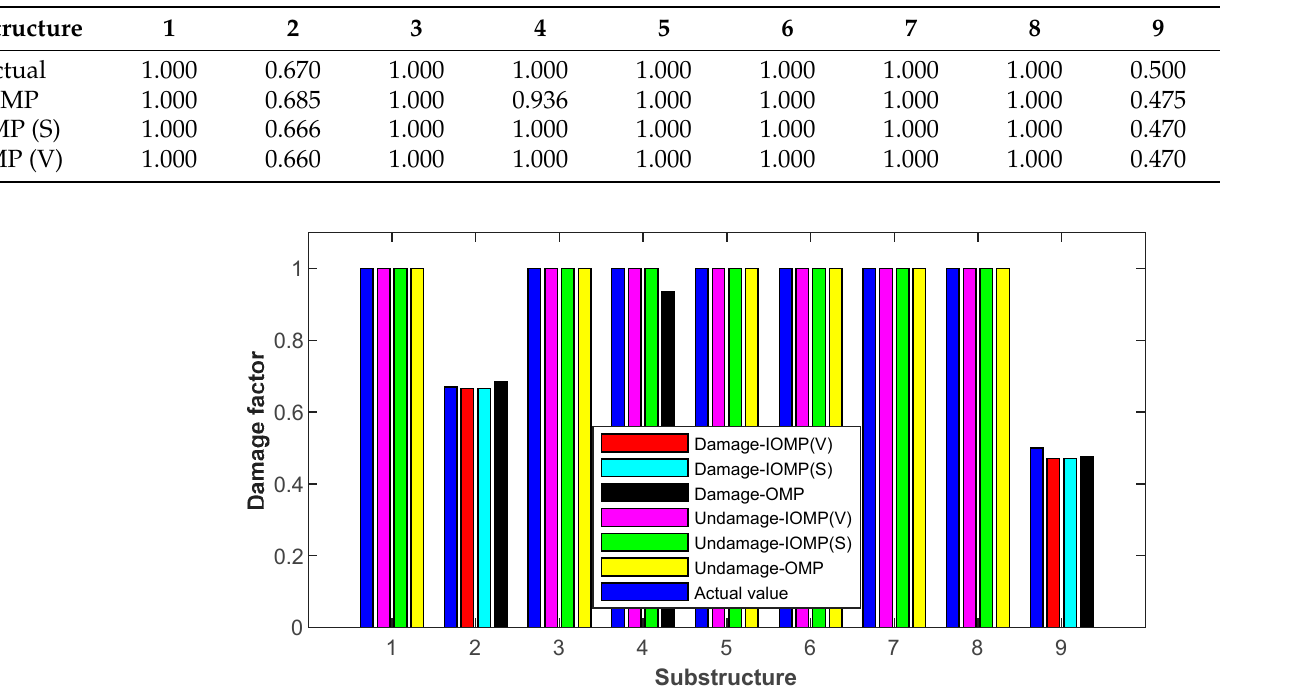
Table 5. Damage factors identification values obtained using OMP and IOMP method.